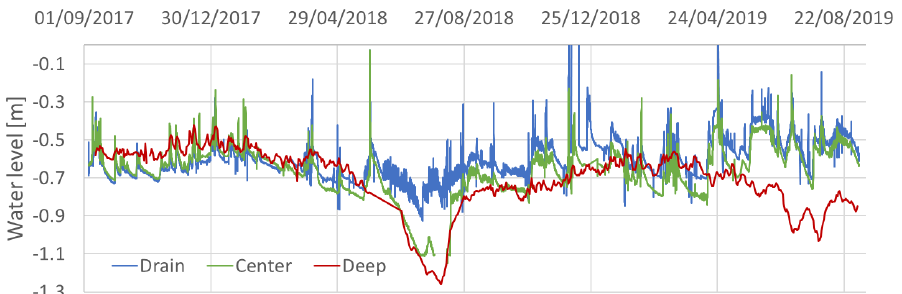
Figure 2. Groundwater levels in the experimental field at Nagele, where the drain well was used to maintain fixed water levels in summer. Drain is on the drain, centre is between the drains and deep is the groundwater level in the deep sand layer (regional). Note that the piezometers were dry at water levels below 1.1m.